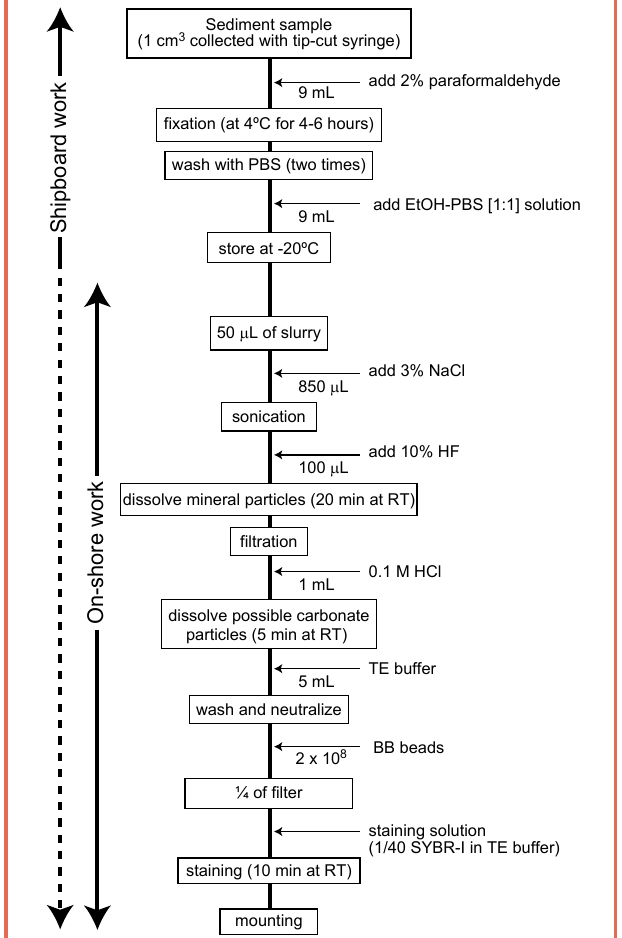
chamber.Figure 2. Flow diagram of standard sample preparation protocol. Up to 3.5 x 10 -3 cm 3 of sediment is mounted on the